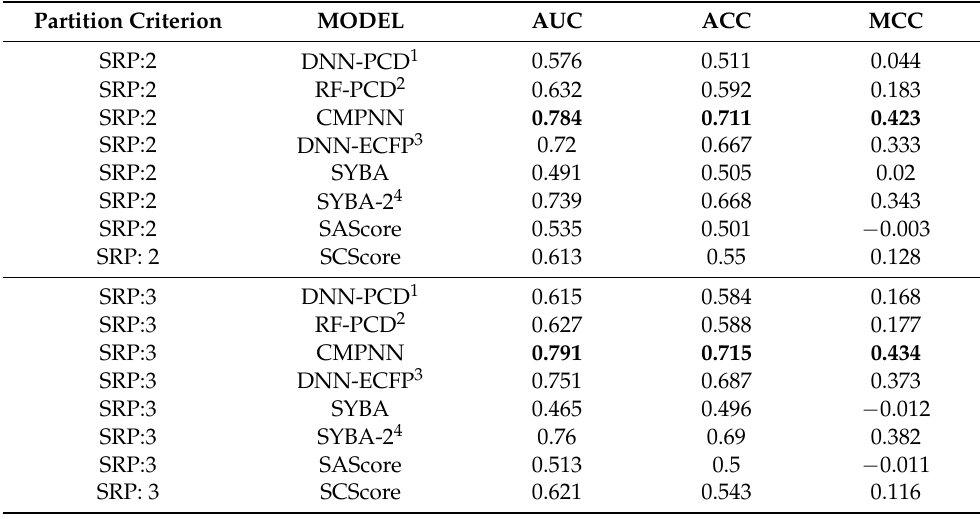
Figure 10. The distribution of physicochemical descriptors on Subset(SRP:3). Table 3. The performance of different models on the balanced test